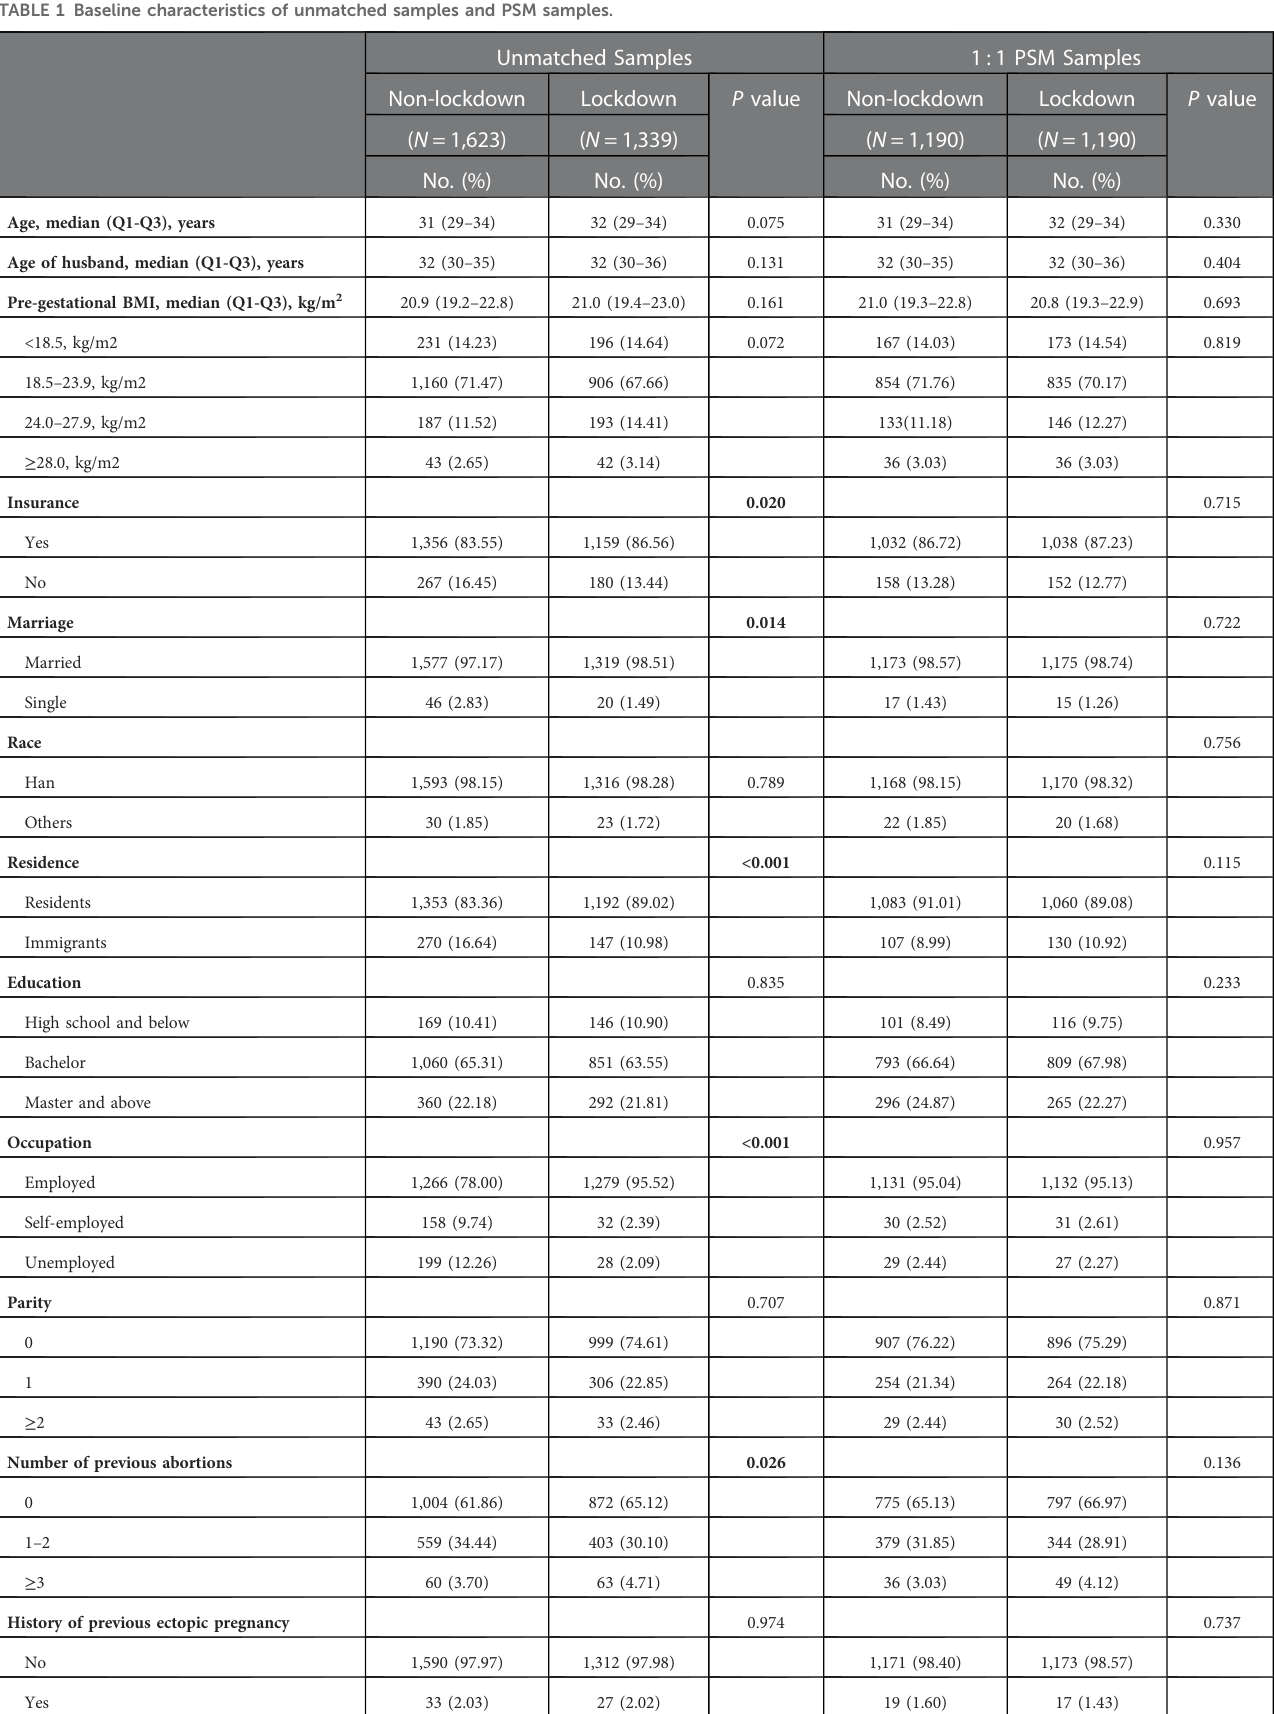
TABLE 1 Baseline characteristics of unmatched samples and PSM